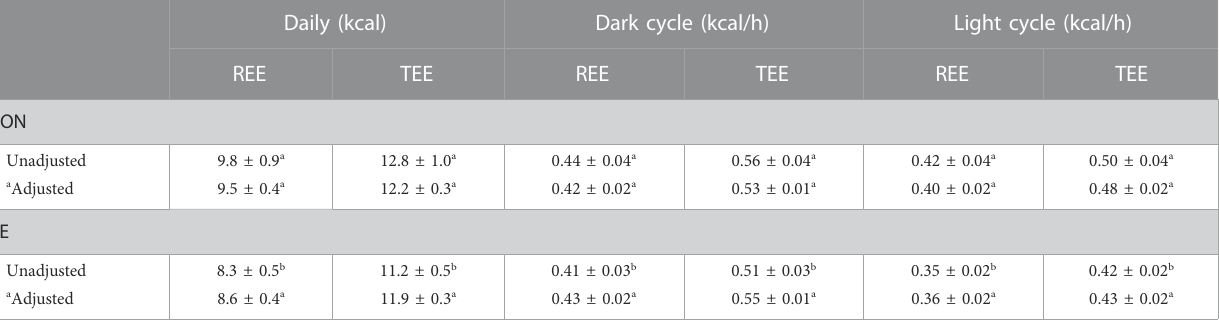
TABLE 1 Resting and total energy expenditure. Daily (kcal) Dark cycle (kcal/h)